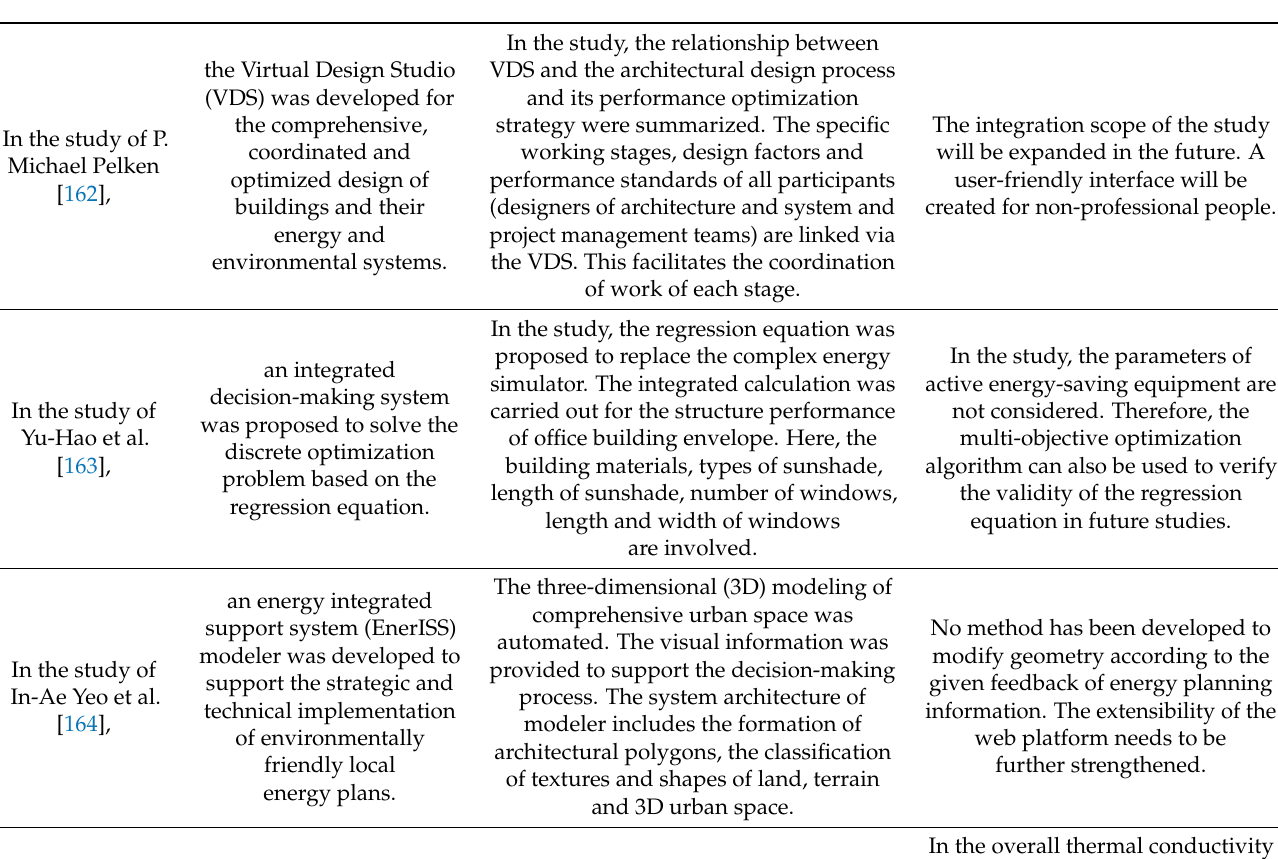
Table 10. Literature related to the development of decision systems based on the calculation of building performance